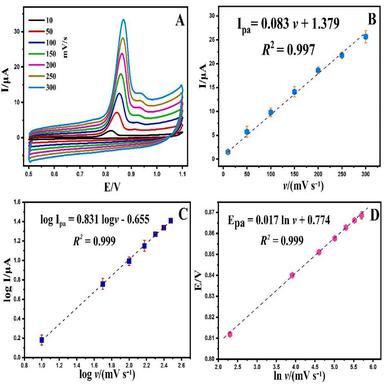
(A) The effect of different scan rates from 10 to 300 mV on CVs curves of RIBO (0.01 mM), (B) υ diagram relative to oxidation of RIBO, (C) dependence of the logarithm current on the logarithm of scan rate, and (D) the corresponding linear curve between ln of the scan rate and the oxidation peak potential at the surface of LaNiO3/g-C3N4@RGH/GCE.